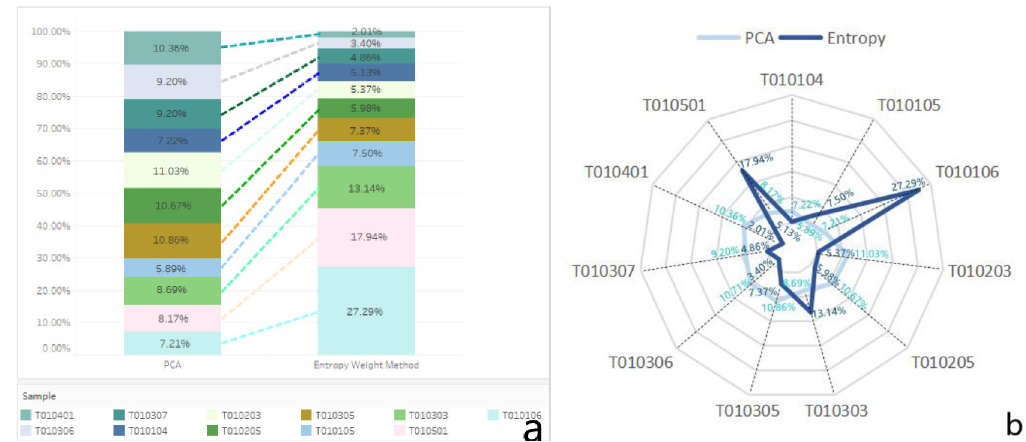
Fig 7. Visualization of comparison of the weighted index in Case Study